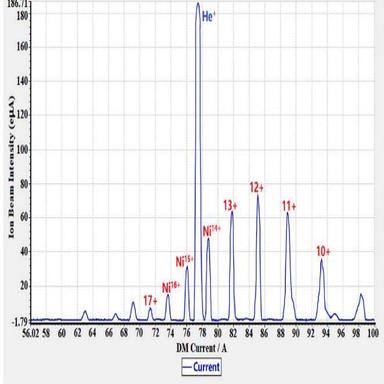
Spectrum with the source optimized for 58Ni15+ (38 eμA) and 4 He+ (186 eμA).